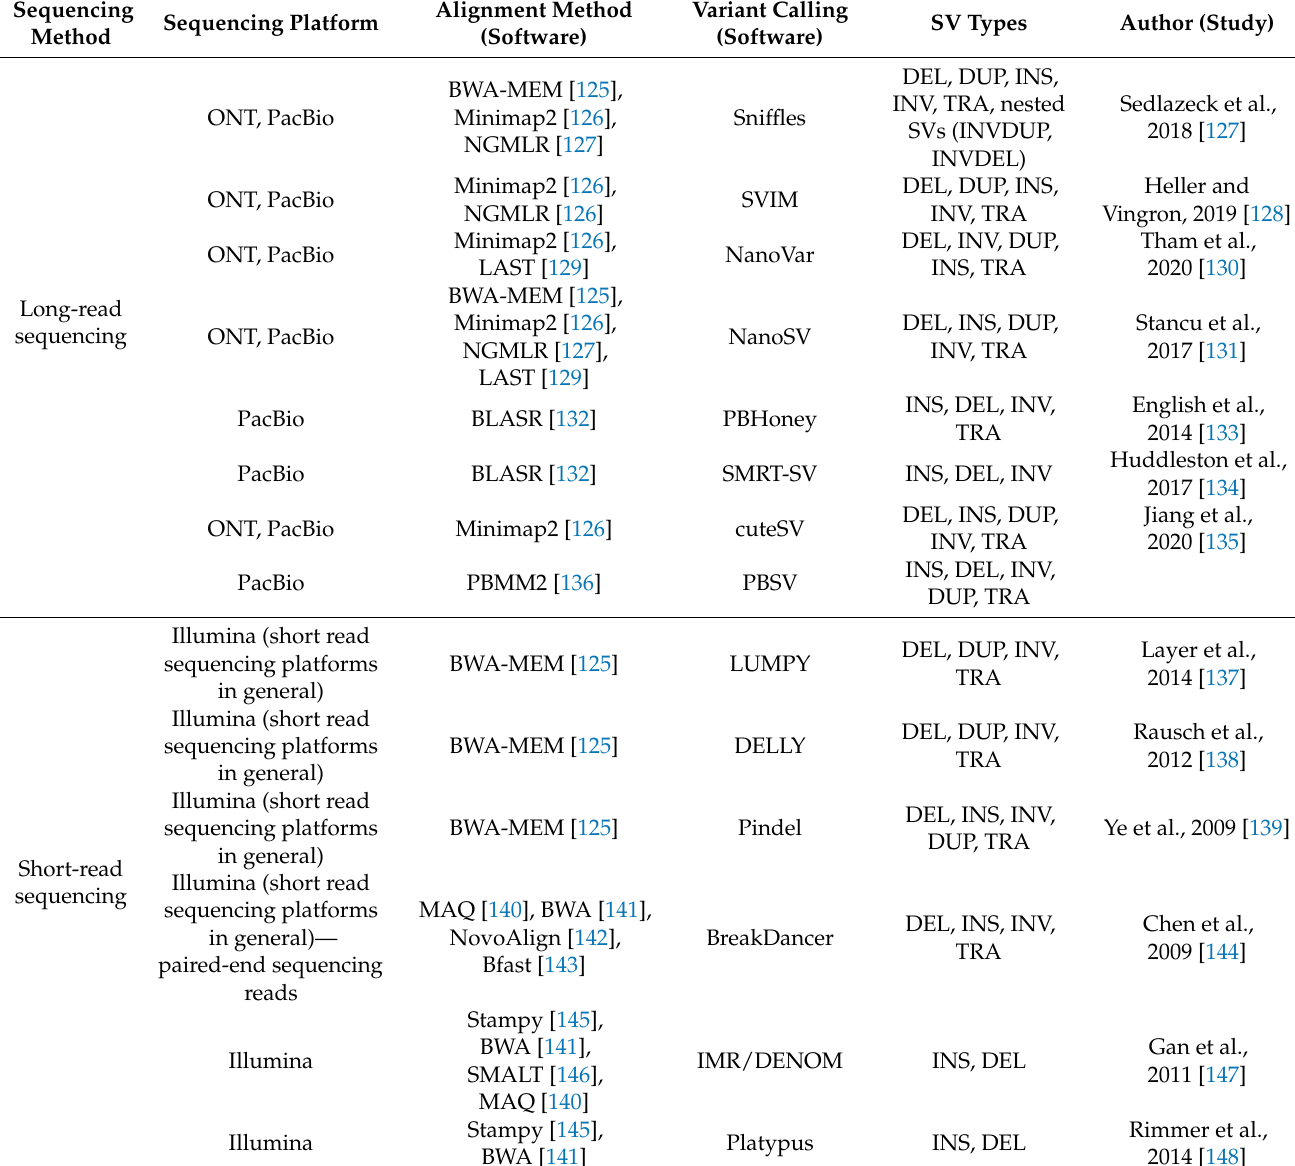
Table 2. Methods to detect structural